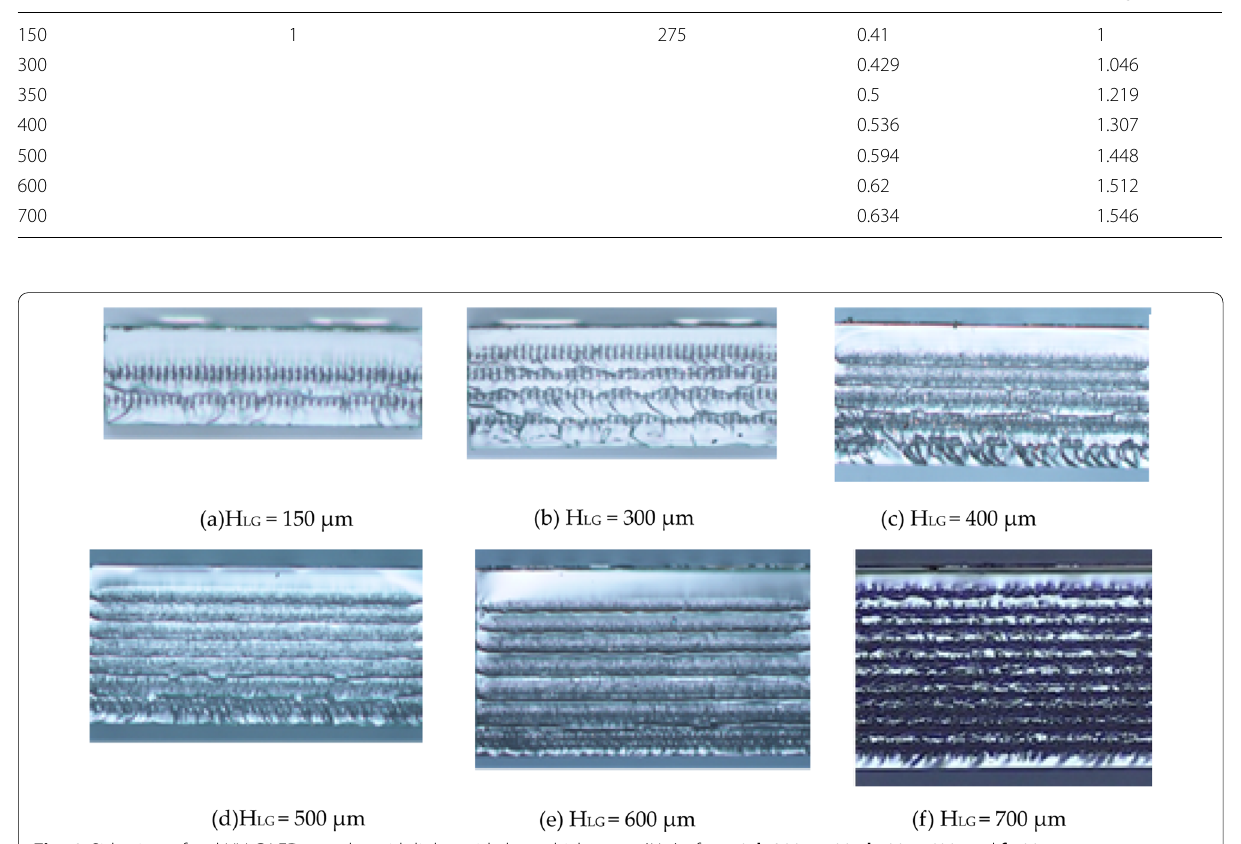
Fig. 6 Side view of real UV‑C LED samples with light guide layer thicknesses ( H LG ) of a 150, b 300, c 400, d 500, e 600, and f 700 μm